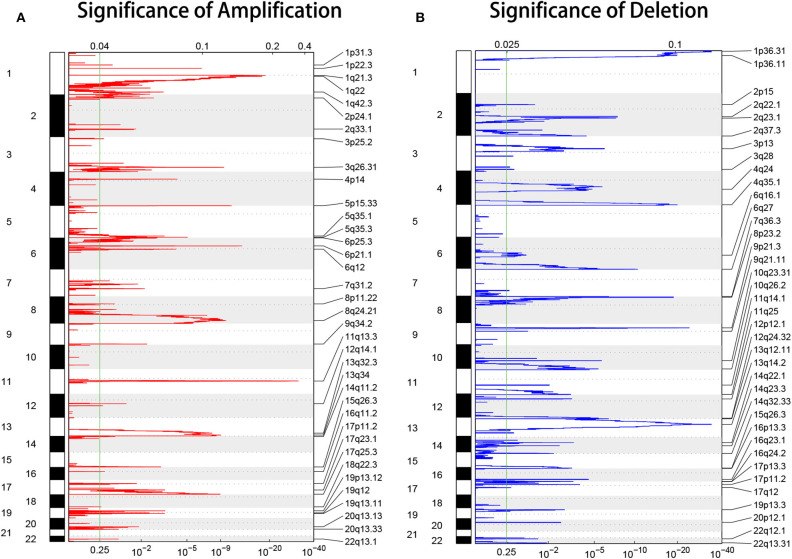
GISTIC heat map showing the genomic copy number profiles from the LIHC cohort in TCGA. (A,B) The gain (red) and loss (blue) of each peak are shown. The x-axes represent the normalized amplification signal (top) and the significance of the q-value (bottom). The green line represents the significance cutoff at a q-value of 0.25.